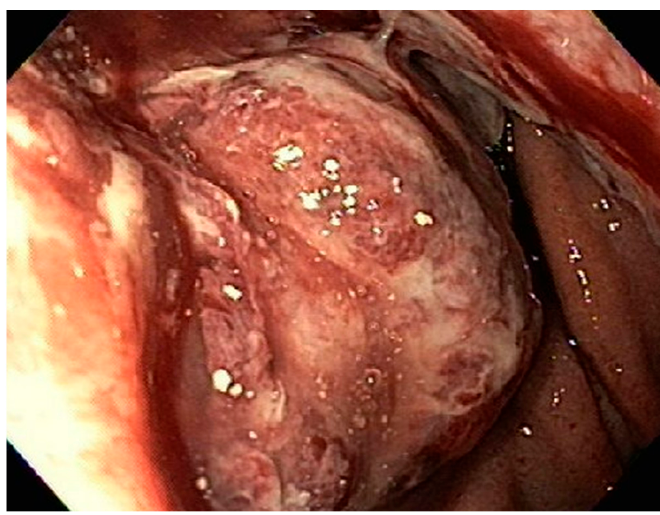
Figure 11. Large necrotic, ulcerated gastric mass noted on upper endoscopy.